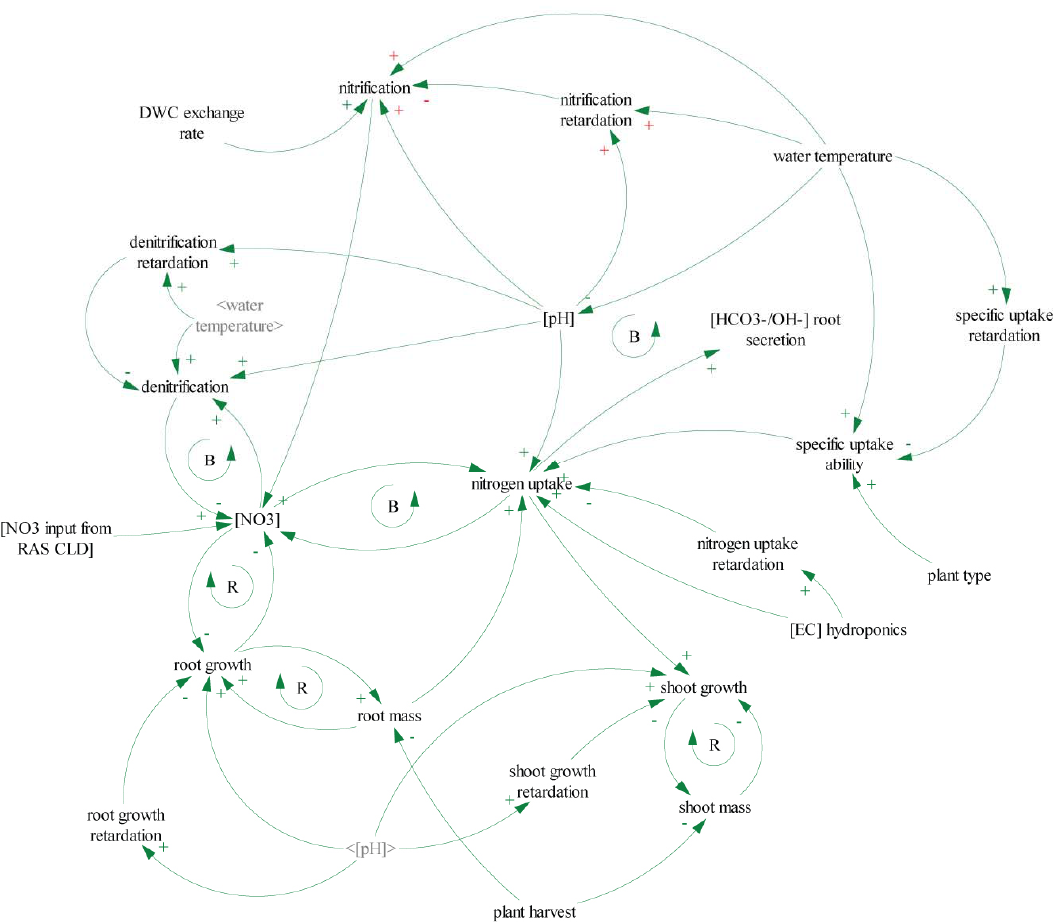
Figure B2. Causal loop diagram (CLD) of nitrogen in hydroponics. This CLD shows the dependencies